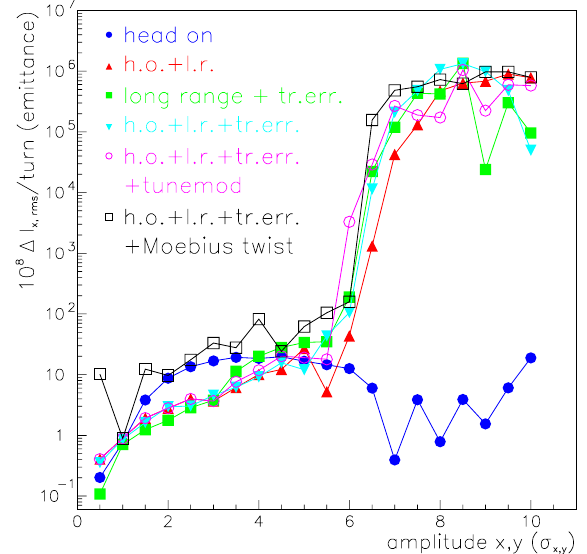
FIG. 8. (Color) The change of action variance per turn as a function of the starting amplitude. Compared are the cases of head-on collisions only, head-on and long-range collisions, long-range collisions plus KEK triplet field errors, both types of collisions plus KEK triplet field errors, the additional effect of a tune modulation at the synchrotron frequency (22 Hz) of amplitude 10 2 4 , and the additional effect of a Möbius twist.